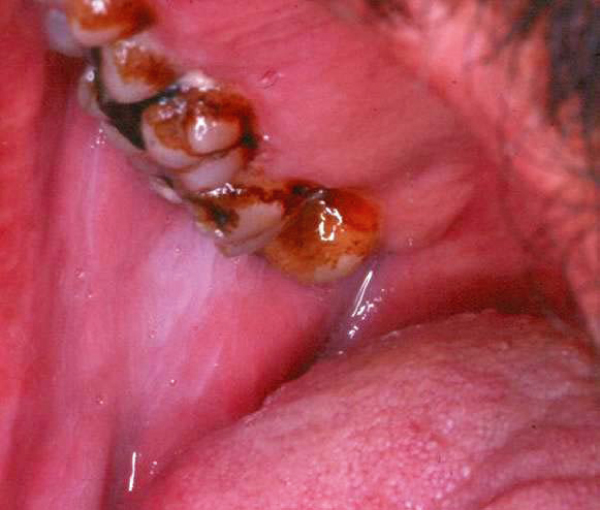
White lesion of the buccal mucosa in a 55-year-old individual who is a non smoker and who chewed khat for over 25 years.